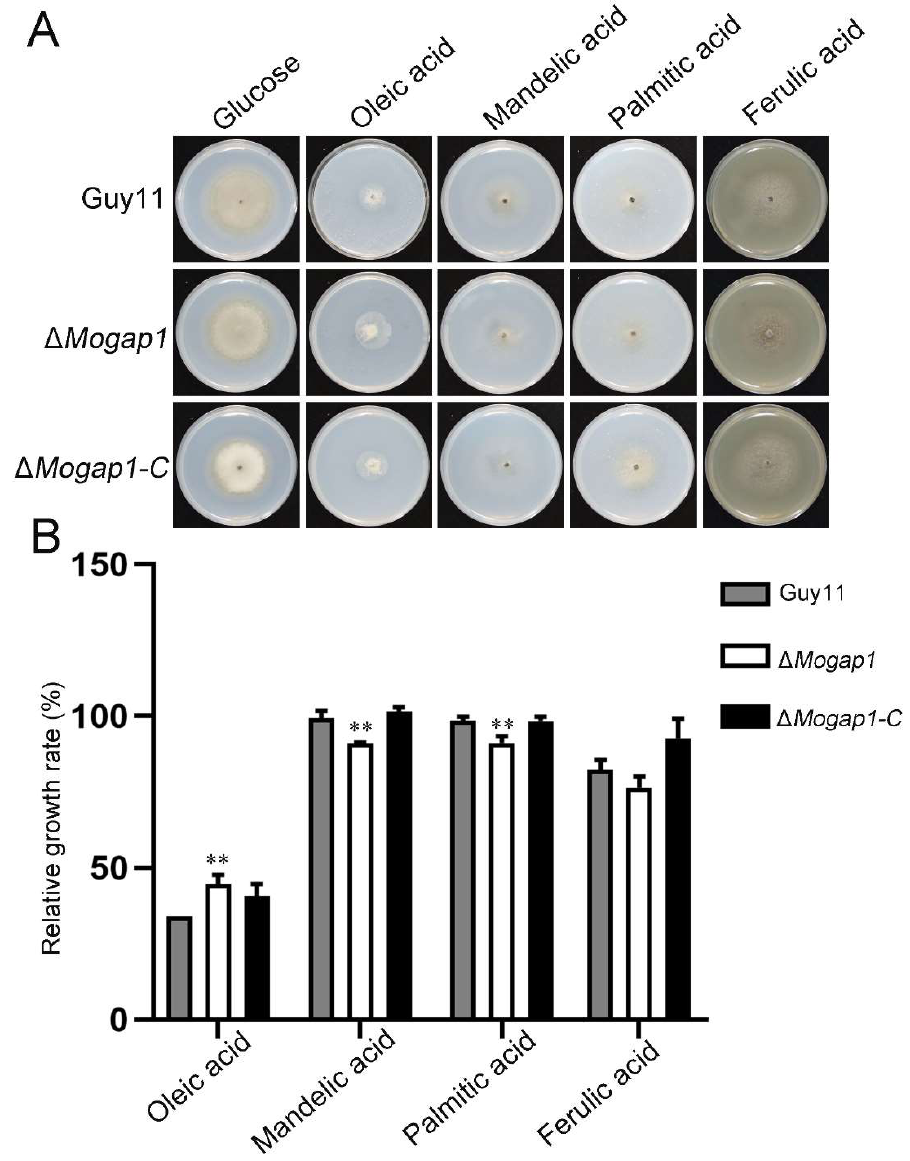
Figure 6. Utilization of different carbon sources in ∆ Mogap1 . ( A ) The growth of Guy11, ∆ Mogap1 , and ∆ Mogap1-C with different C sources. ( B ) The relative growth rates of Guy11, ∆ Mogap1 , and ∆ Mogap1-C with different C sources. With oleic acid, mandelic acid, or palmitic acid as the C source, the relative growth rates of Guy11 and Δ Mogap1 were significantly different from each other. ** p < 0.01.